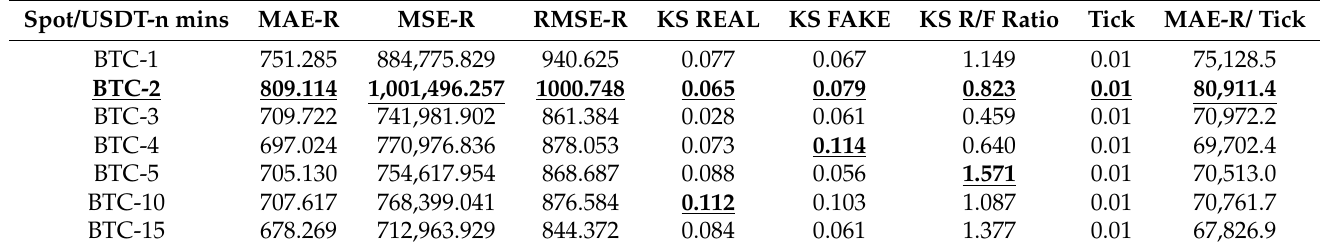
Table 9. We examined BTC spot prices against generated prices at intervals of one, two, three, four, five, ten and fifteen minutes. For the KS R/F Ratio, four out of seven are more significant than one, indicating hard to train, where the highest KS REAL and FAKE are 0.112 and 0.114.